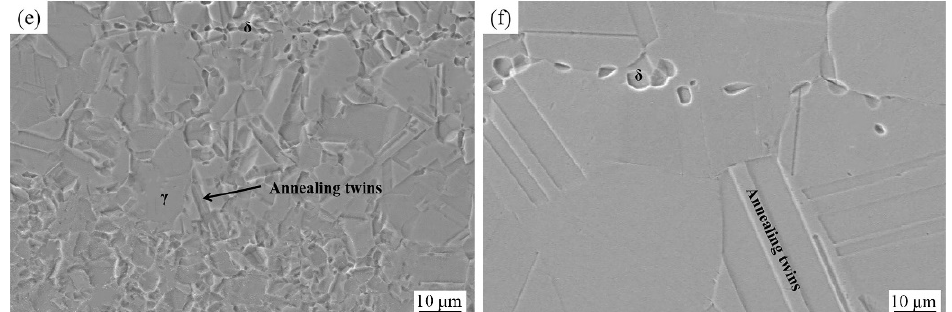
Figure 2. SEM (scanning electron microscope) micrographs of steel 1# under different solid solution temperatures: ( a ) 650 °C, ( b ) 750 °C, ( c ) 800 °C, ( d ) 850 °C, ( e ) 900 °C and ( f ) 1050 °C. ( δ : δ -ferrite; γ : austenite.)